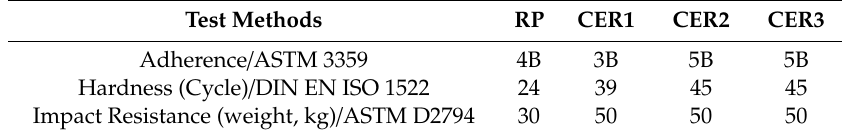
Table 3. Mechanical properties of coatings according to international standard test